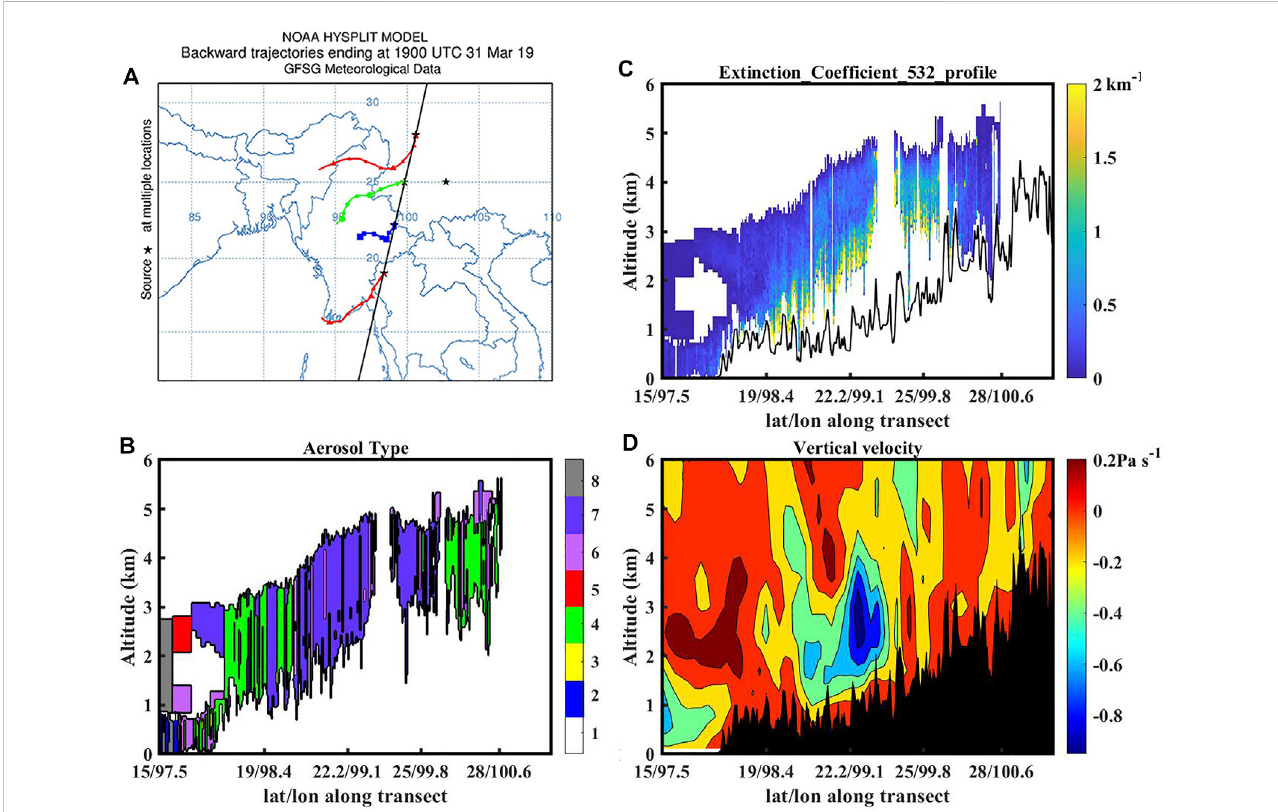
FIGURE 5 (A) The48-hbackwardtrajectoriesofairparcelsendingat0 maltitudeatthe4locationsontheCALIPSOsatelliteorbittracks.CALIPSOverticalpro fi lesof (B) aerosol types (where 1 = not determined, 2 = clear marine, 3 = dust, 4 = polluted continental, 5 = clear continental, 6 = polluted dust, 7 = smoke, and 8 = other) and (C) aerosol extinctioncoef fi cient (km − 1 )(the blackline represents surfaceelevation) at19:22 – 19:26 UTC on 31 March 2019, (D) Vertical velocity (Pa s − 1 ) at 18:00 UTC on 31 March